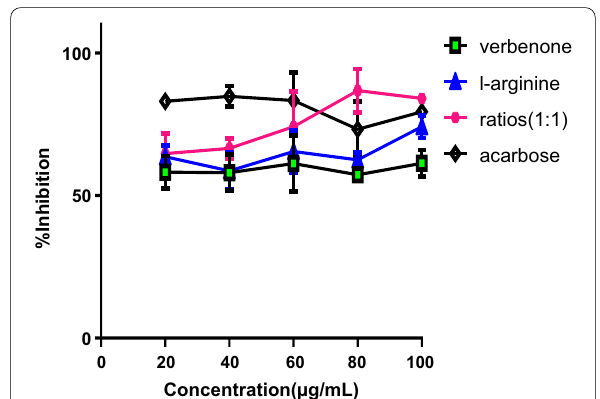
Fig. 3 α-Glucosidases inhibitory activity of verbenone, L-arginine and ratios of verbenone L-arginine (1:1 v/m). Values are + expressed as mean SEM, triplicated determinations. Ratios ± (1:1) verbenone L-arginine (1:1 v/m) = +